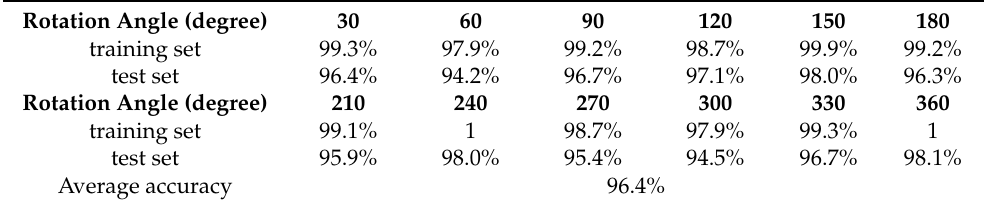
Classification accuracy corresponding to the different rotation